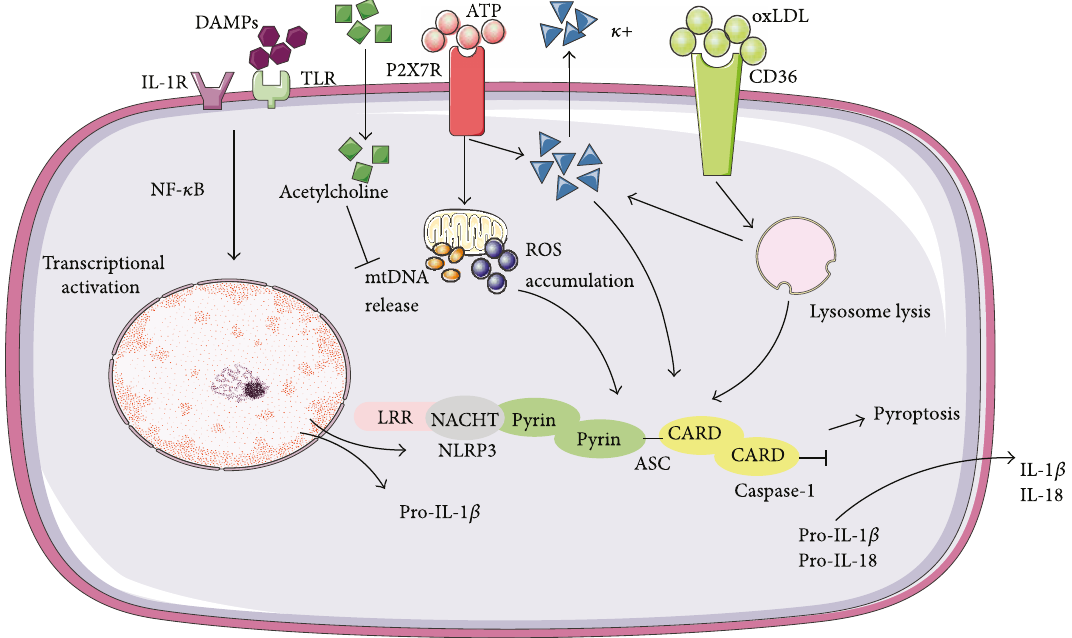
Figure 1: Overall scheme of NLRP3 in fl ammasome